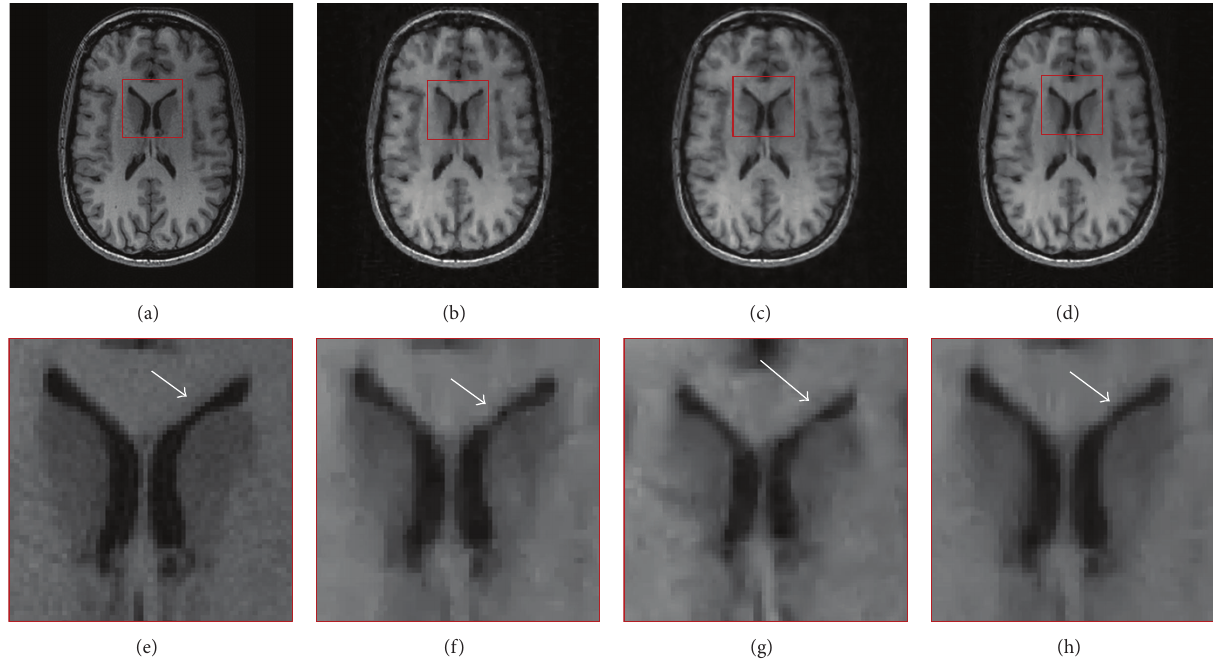
Figure 10: Original axial brain image and experimental results. (a) Original axial brain image. Reconstruction at sampling rate 0.2 by (b) CS;